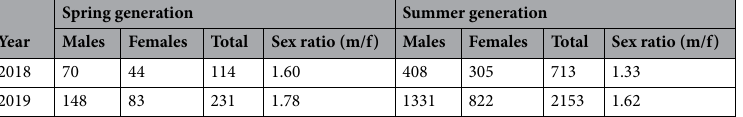
Table 1. Sample sizes of L. helle captured through mark-capture surveys in the Dębnicko-Tyniecki Obszar Łąkowy, southern Poland.